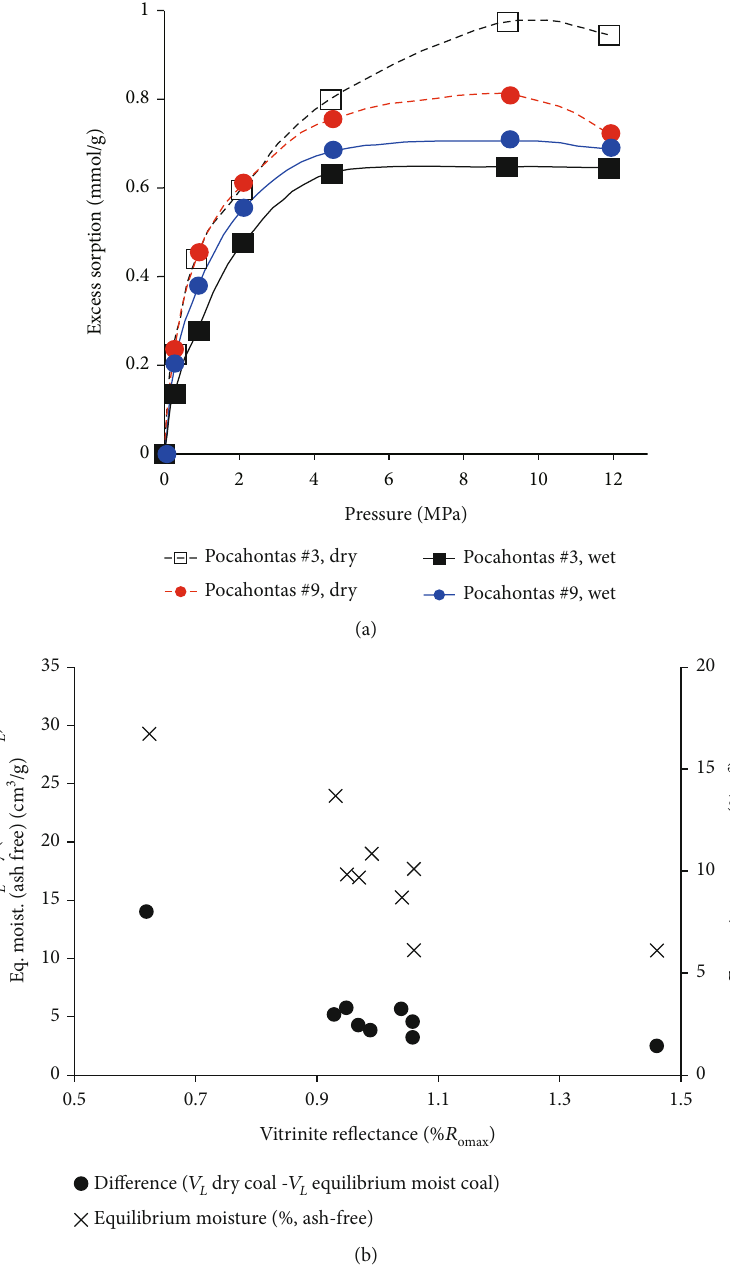
Figure 18: Variations of gas adsorption behavior with moisture in coal reservoirs: (a) CO dry Appalachian coals; (b) di ff erence of V Laxminarayana and Crosdale